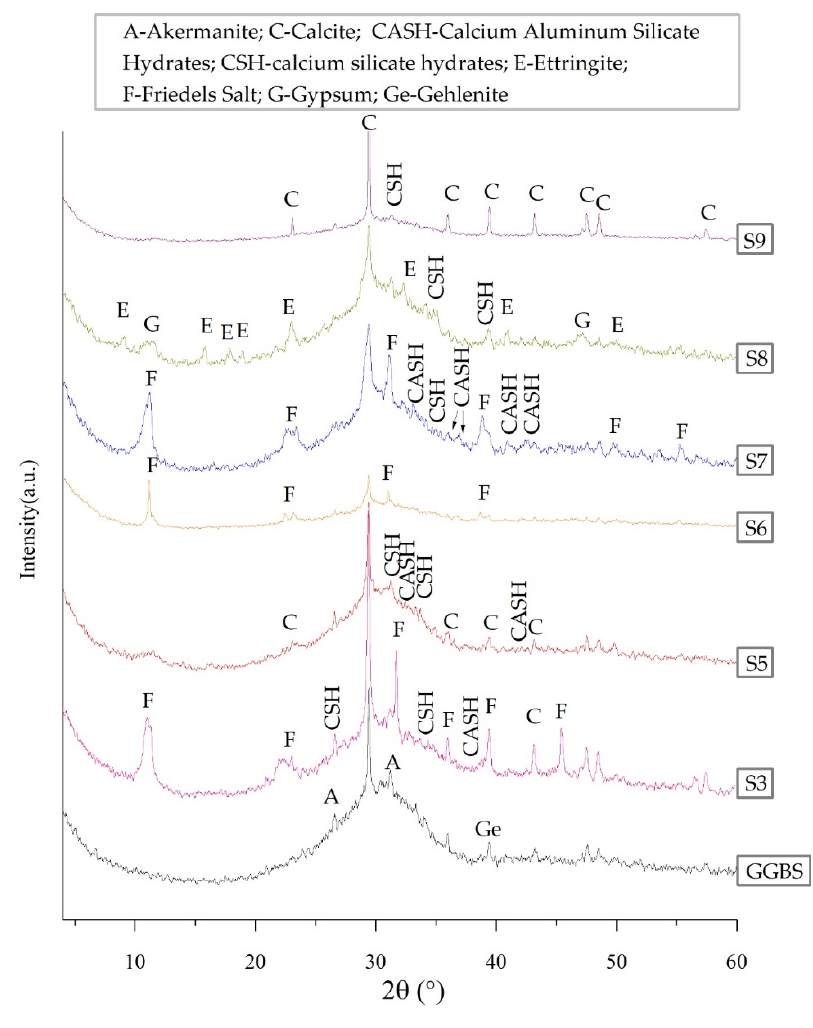
Figure 6. XRD patterns of raw GGBS and AAS pastes (S3, S5, S6, S7, S8, and S9) at 28 d.